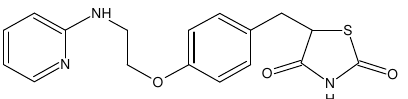
Figure 1. The chemical structure of rosiglitazone and